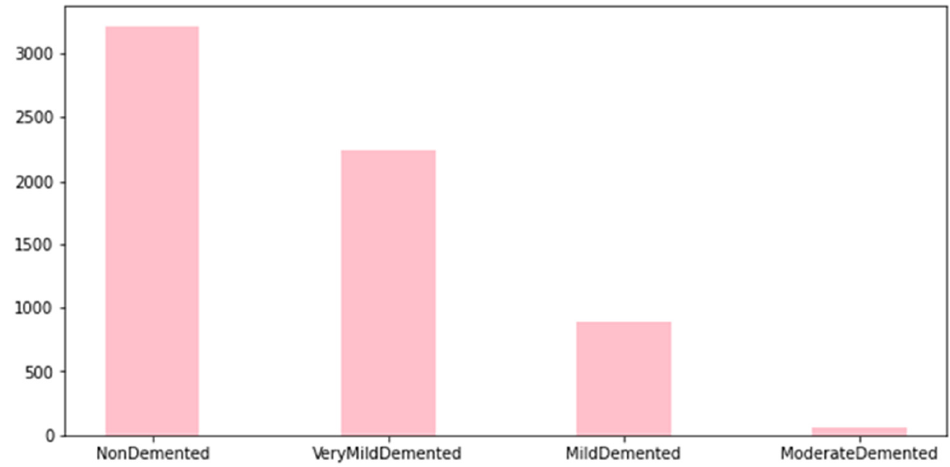
Figure 2. Statistics of Kaggle dataset [29].